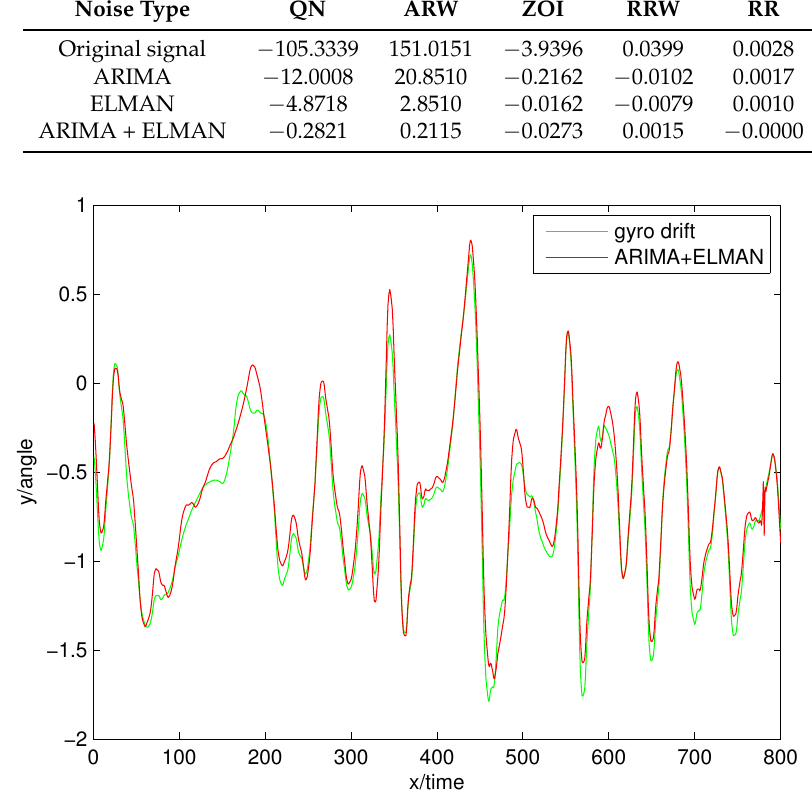
Figure 9. Approximation results based on the ARIMA-Elman